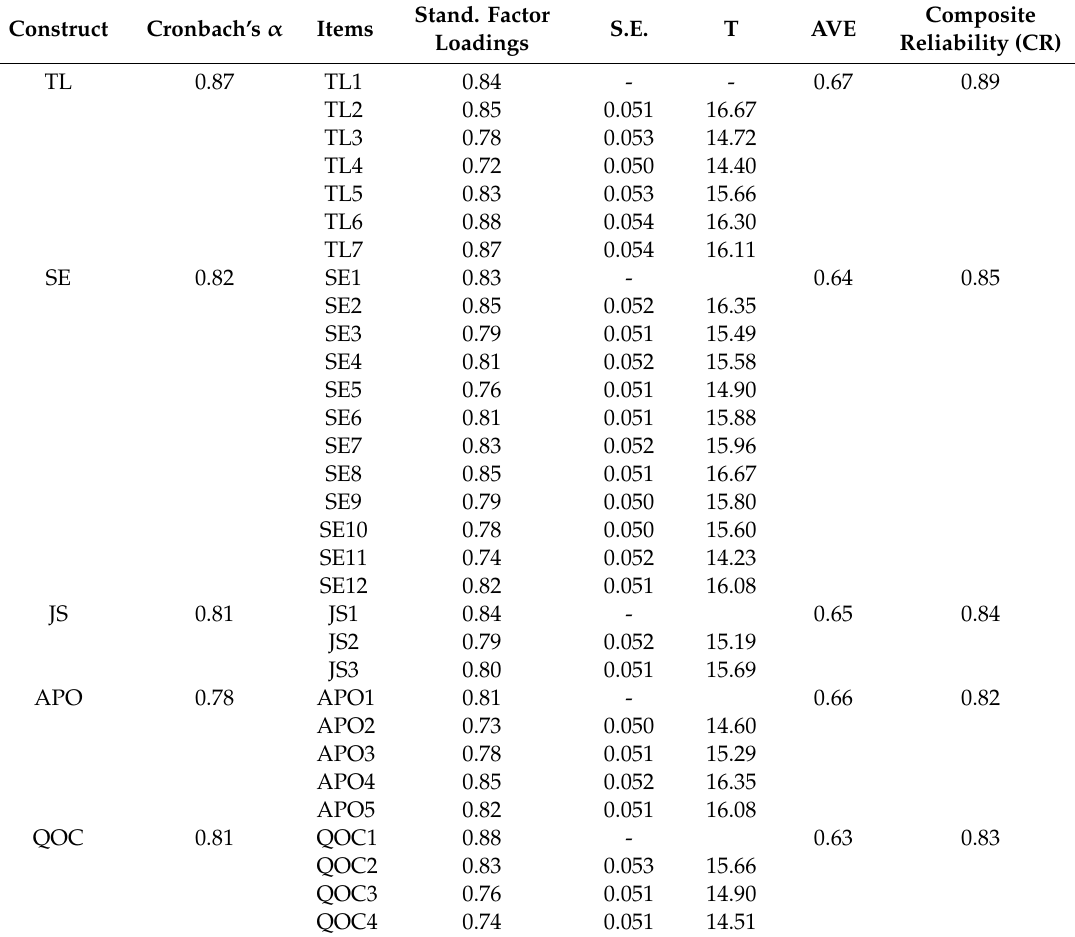
Table 3. Overall measurement model.